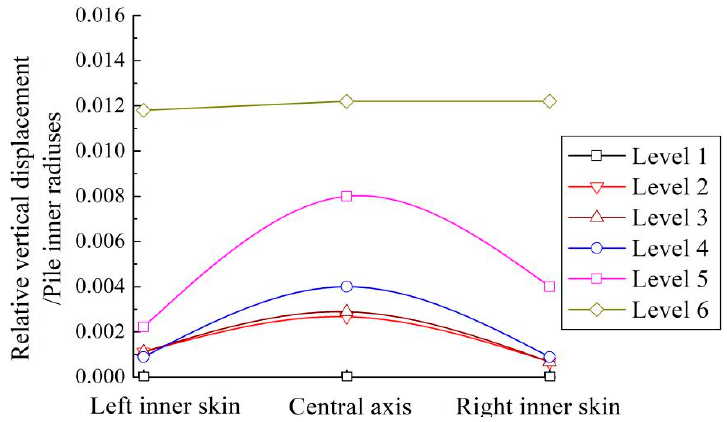
Figure 19. Relative vertical displacements at six levels inside the pile.